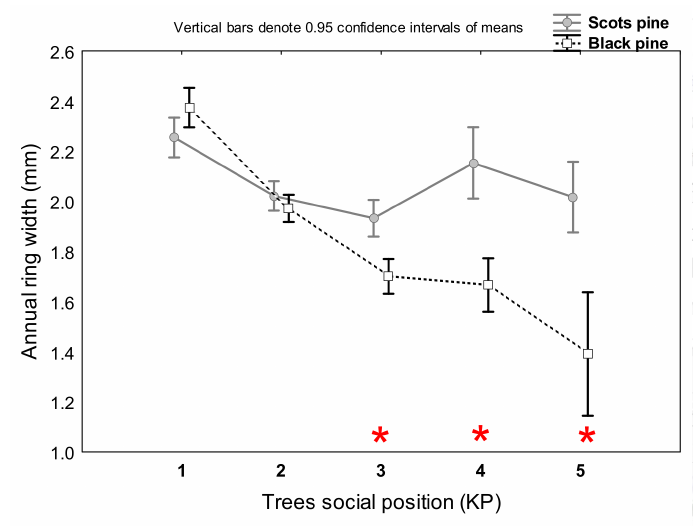
Figure 3. Distinguishing between social classes stand in terms of radial growth (1: dominant; 2: codominant; 3: subdominant; 4: suppressed; 5: dying. Stars mark significant differences: p < 0.001).